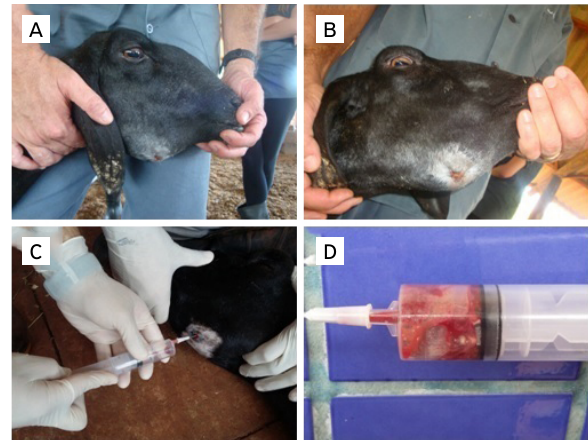
Figure 3. Actinomycosis in ovine: (A) increased volume of hard consistency in the mandibular region; (B) ulceration of the skin with the presence of fistula; (C) puncture of the fistula to collect material for bacterial isolation; (D) yellowish purulent secretion, creamy, contaminated with blood and with the presence of small and hard granules similar to the sulfur granules.